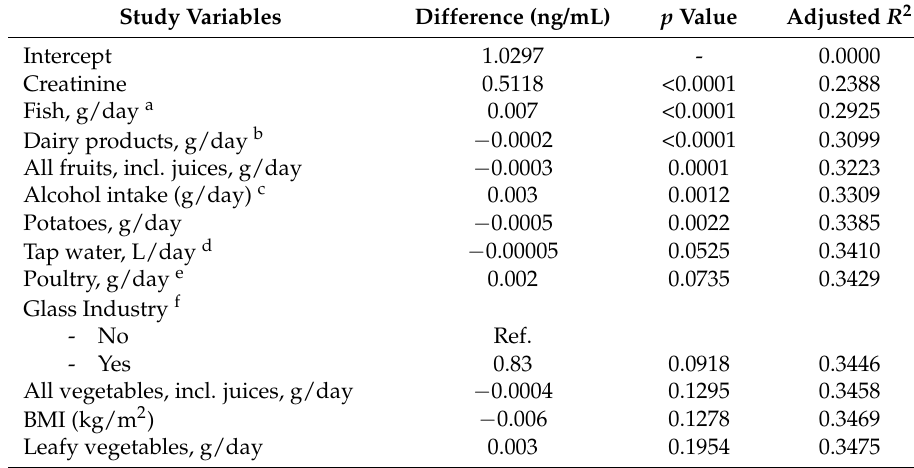
Table 4. Association between log 10 -transformed urinary arsenic levels and baseline study characteristics. Results of forward regression